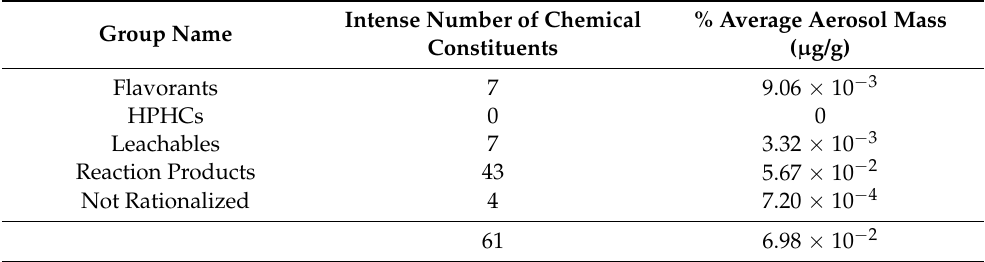
Table 10. Chemical constituents exclusive to JUUL Me5 aerosol compared to cigarette